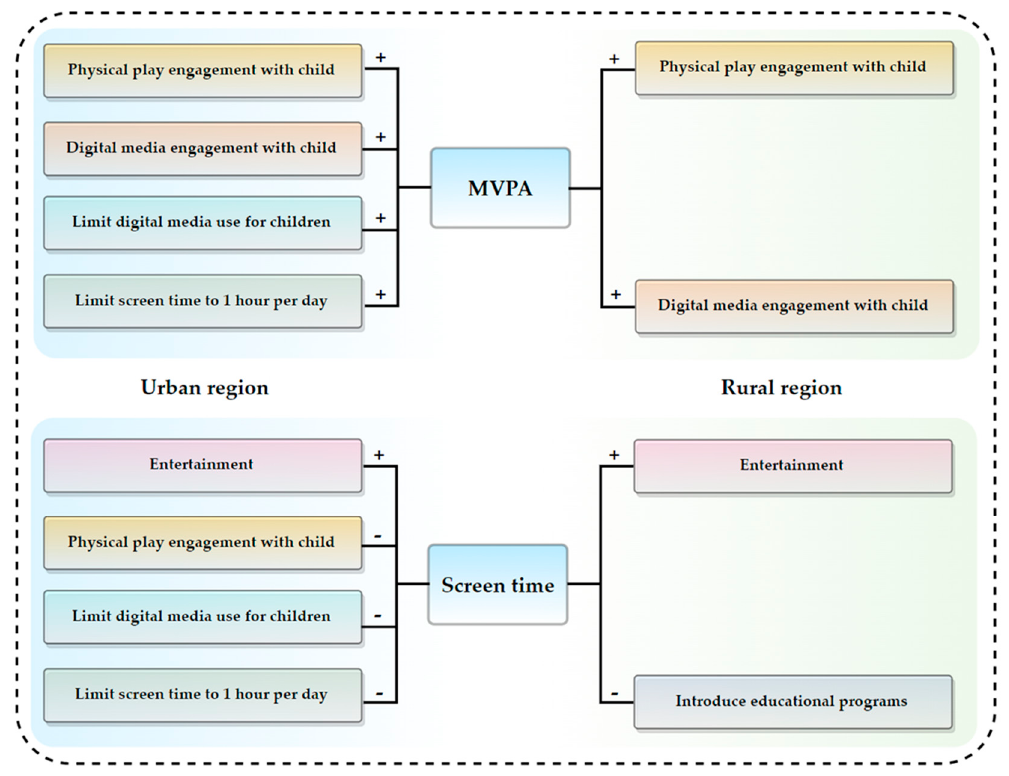
Figure 1. Proposed the relationships between urban/rural parents’ digital media habits, engagement, awareness, and 24-h MG for preschool children.